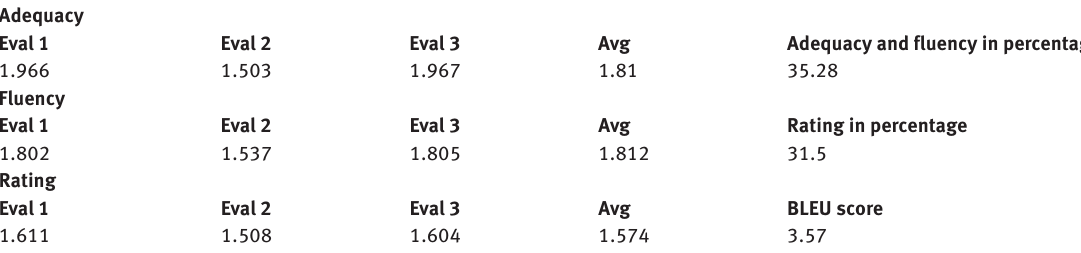
Table 3: Result of Evaluation Indicating Adequacy, Fluency, Rating, and BLEU Score when Evaluated with script provided by the